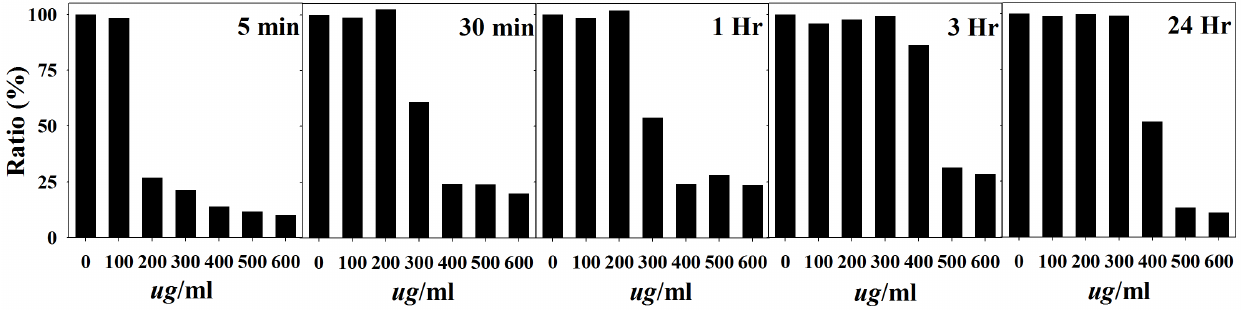
Figure 1. Inhibitory effects of the MOL extract on the proliferation of A549 lung adenocarcinoma cells. The MOL extract was obtained after extraction with cold DW for 5 min to 24 h and administered to the A549 cells, and the MTT assay conducted after 2-d incubation. Data were averaged from 3 independent experiments, and the variations were below 10%. doi:10.1371/journal.pone.0095492.g001 PLOS ONE |